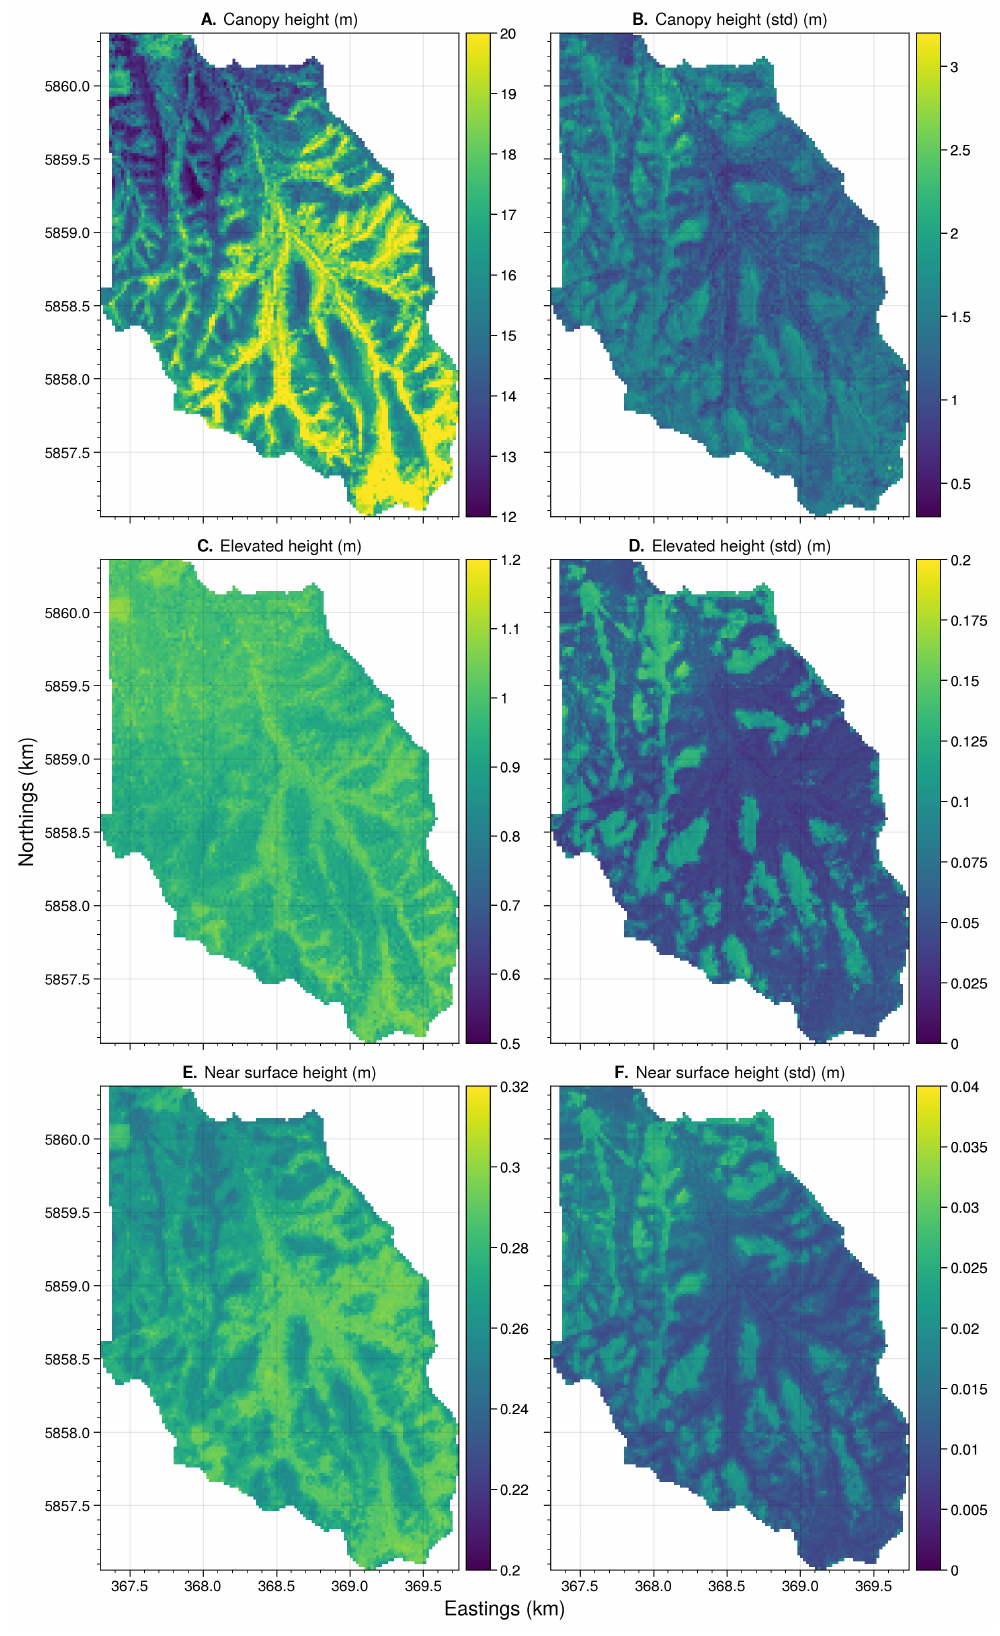
Figure A12. The mean and standard deviation predictions at landscape level for canopy ( A , B ), elevated ( C , D ), and near-surface ( E , F ) fuel height using TLS observations at